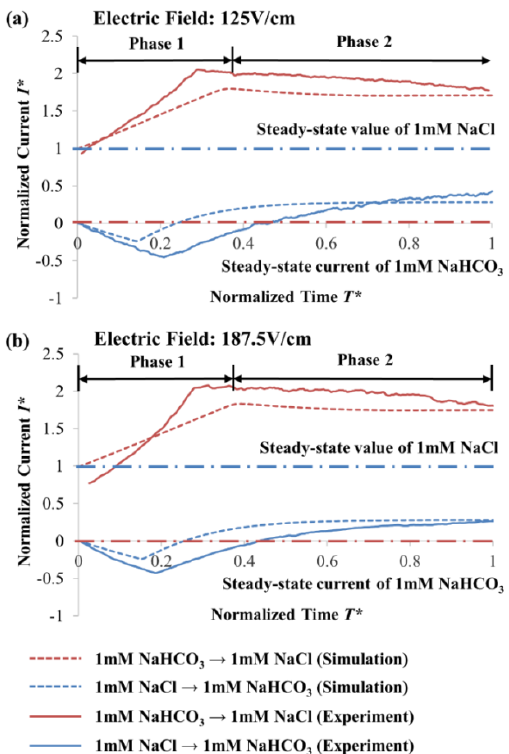
Figure 9. Electroosmotic displacement flow of the 1mM NaCl–NaHCO 3 solution pair at applied elec- tric field of ( a ) 125 V · cm − 1 and ( b ) 187.5 V · cm − 1 , whereby numerical simulation and experimental results are compared. Normalized currents and times are calculated with I* = ( I − I 0 NaHCO 3 )/( I 0 NaCl − I 0NaHCO3 ) and T* = T / T SSNaCl → NaHCO3 respectively, where initial currents of solutions are represented by I 0 with NaHCO 3 and NaCl subscripts respectively, and the time to reach steady-state current for NaCl → NaHCO 3 (arrow indicates EOF direction) is represented by T SSNaCl → NaHCO3 .